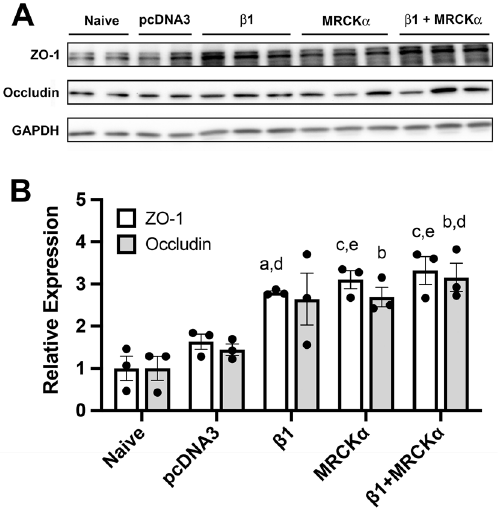
Figure 1. Overexpression MRCKα increases tight junction protein expression in healthy mouse lungs. Plasmids (100 µg each) expressing either no insert (pcDNA3), the β1 subunit of the Na + ,K + -ATPase (β1), MRCKα, or β1 and MRCKα were delivered in 50 µl to the lungs of C75B6 mice (n = 3) by aspiration followed immediately by electroporation (8 pulses of 10 ms duration each and 200 V/cm). Two days later, lungs were perfused with PBS and lysates were prepared for analysis by Western Blot ( A ). Levels of expression were normalized to GAPDH as a loading control and the relative expression of ZO-1 (white bars) and Occludin (grey bars) are shown as mean ± SEM ( B ). All experiments were carried out three times and a representative experiment is shown. One- way ANOVA with post-hoc Tukey’s multiple comparisons was used for statistical analysis; a, p < 0.01 compared to naïve; b, p < 0.05 compared to naïve; c, p < 0.001 compared to naïve; d, p < 0.05 compared to pcDNA3; e, p < 0.01 compared to pcDNA3.